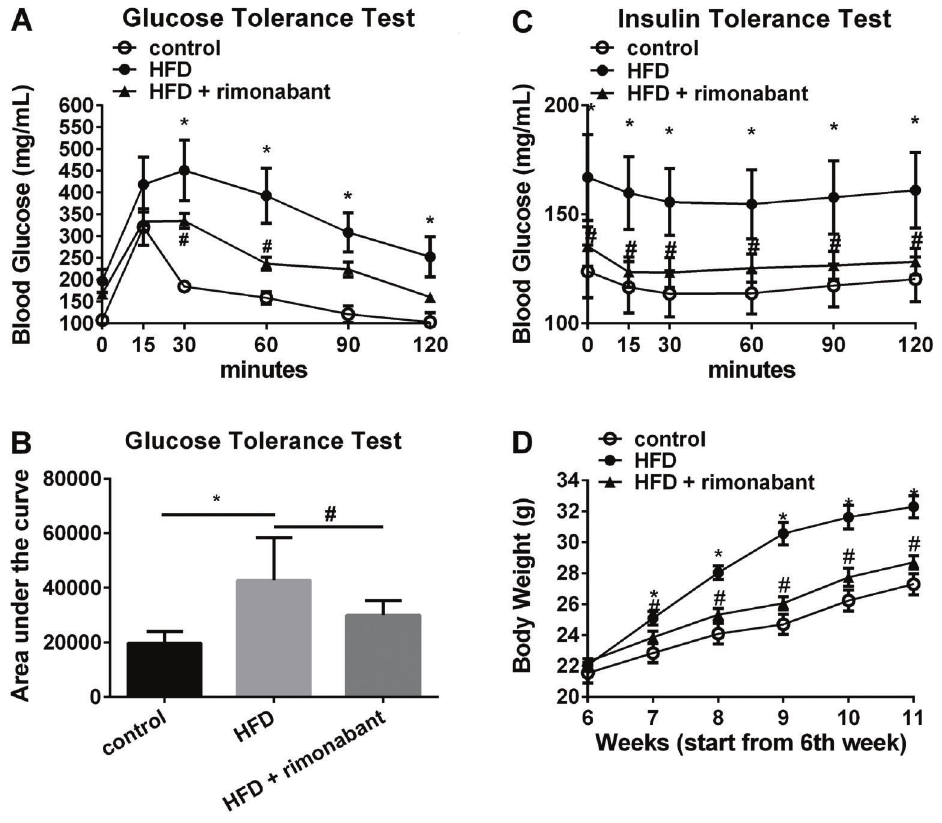
Figure 1. A , Glucose tolerance in mice fed a regular diet (control, n=6 mice), a high-fat diet (HFD, n=6 mice), or HFD + rimonabant (n=10) ( A and B ). C , Insulin tolerance test results for control (n=4 mice), HFD (n=4 mice) and HFD + rimonabant (n=4 mice) groups. D , Body weight of control (n=10 mice), HFD (n=10 mice) and HFD + rimonabant groups (n=14 mice) over a 5-week period. Results are reported as means ± SE. *P o 0.05 HFD vs control, # P o 0.05 HFD vs HFD + rimonabant ( A , C and D, two-way ANOVA with Tukey ’ s multiple comparisons. B , one-way